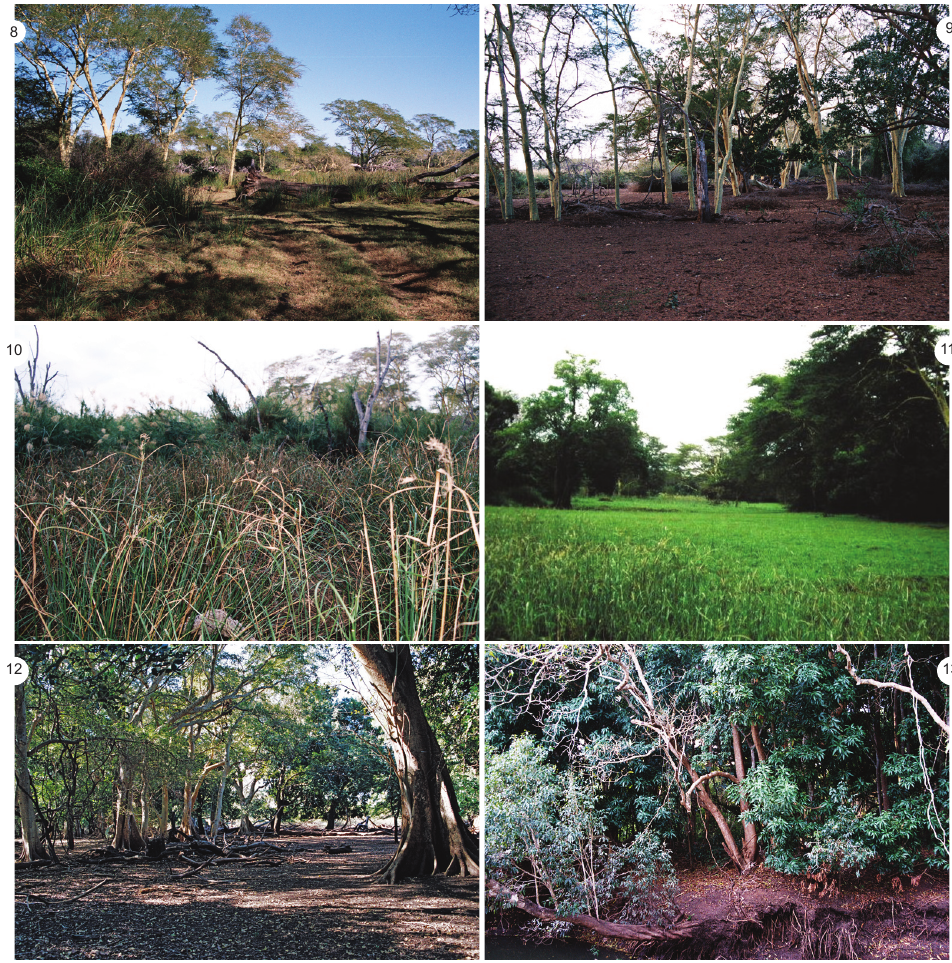
Figs. 8–13. Floodplain and associated habitats in Ndumo Game Reserve: 8–9) Fever tree or Acacia xantho- phloea forests at Shokwe pan (8) and Banzi pan (9). Note the differences in understory plant growth; 10–11) Floodplain vegetation (FP); 12) Wild fig or Ficus forest (FF) at Shokwe pan; 13) Riparian forest (RF) at the Pongola